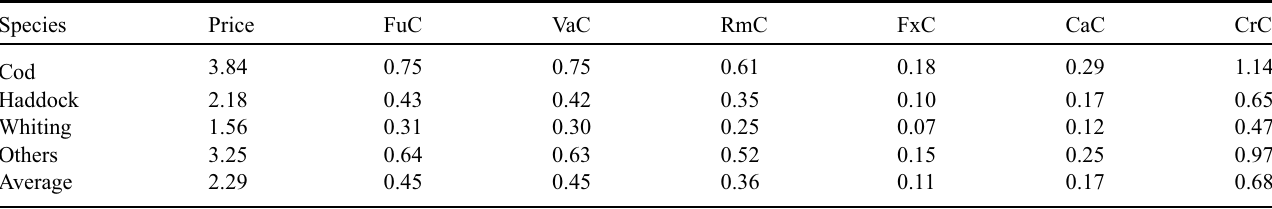
Table A.5. Price and cost structure (fuel costs (FuC), other variable costs (VaC), crew costs (CrC), repair and maintenance costs (RmC), fi xed costs (FxC), capital costs (CaC)) of main species exploited in the CHW fi shery (cod, haddock, whiting) by the polyvalent general þ 18 m fl eet segment in 2019.